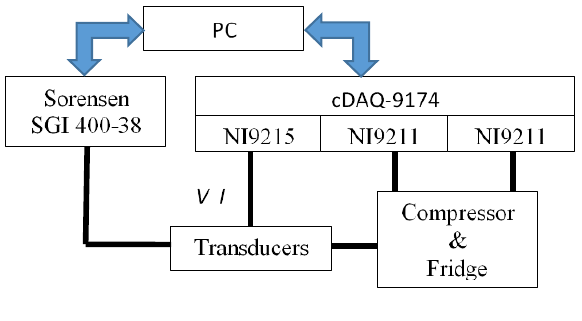
Figure 5. Experimental setup.